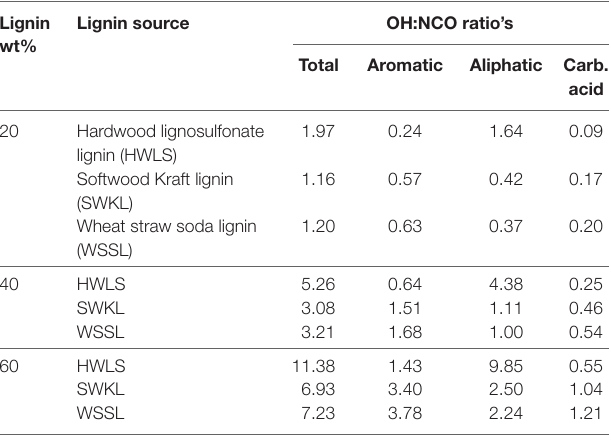
Total aromatic aliphatic carb.